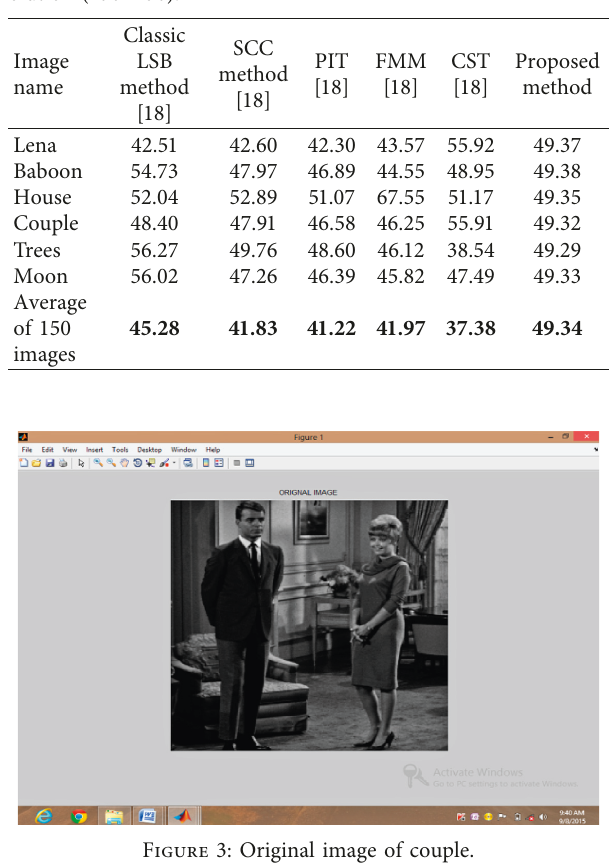
Table 7: Comparison of the proposed method with other tech- niques based on PSNR by hiding 8KB of data in images of res- olution (256 ∗ 256).